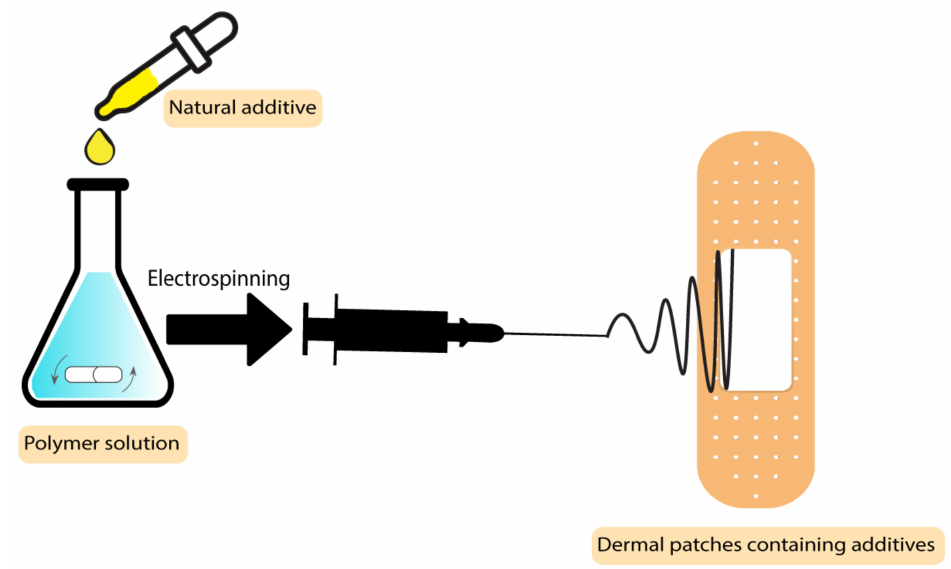
Figure 6. Process scheme of dermal patches containing natural